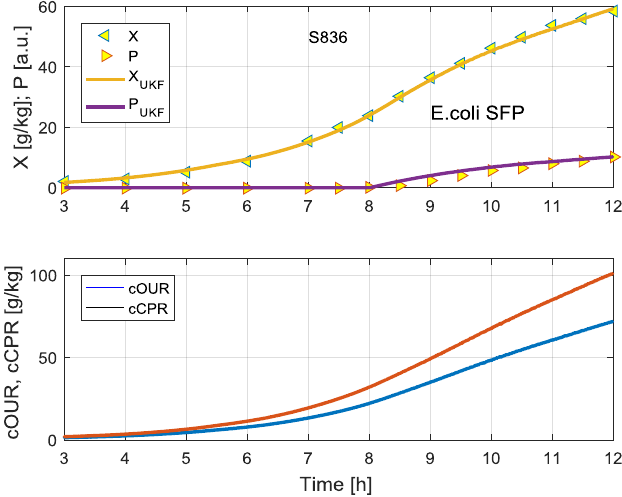
Figure 3. Typical result for the study S836: In the upper plot, the biomass and the product concentration data are displayed as symbols together with the Unscented Kalman Filter (UKF) estimates (lines). In the lower plot the measurement data used in the estimates are depicted.